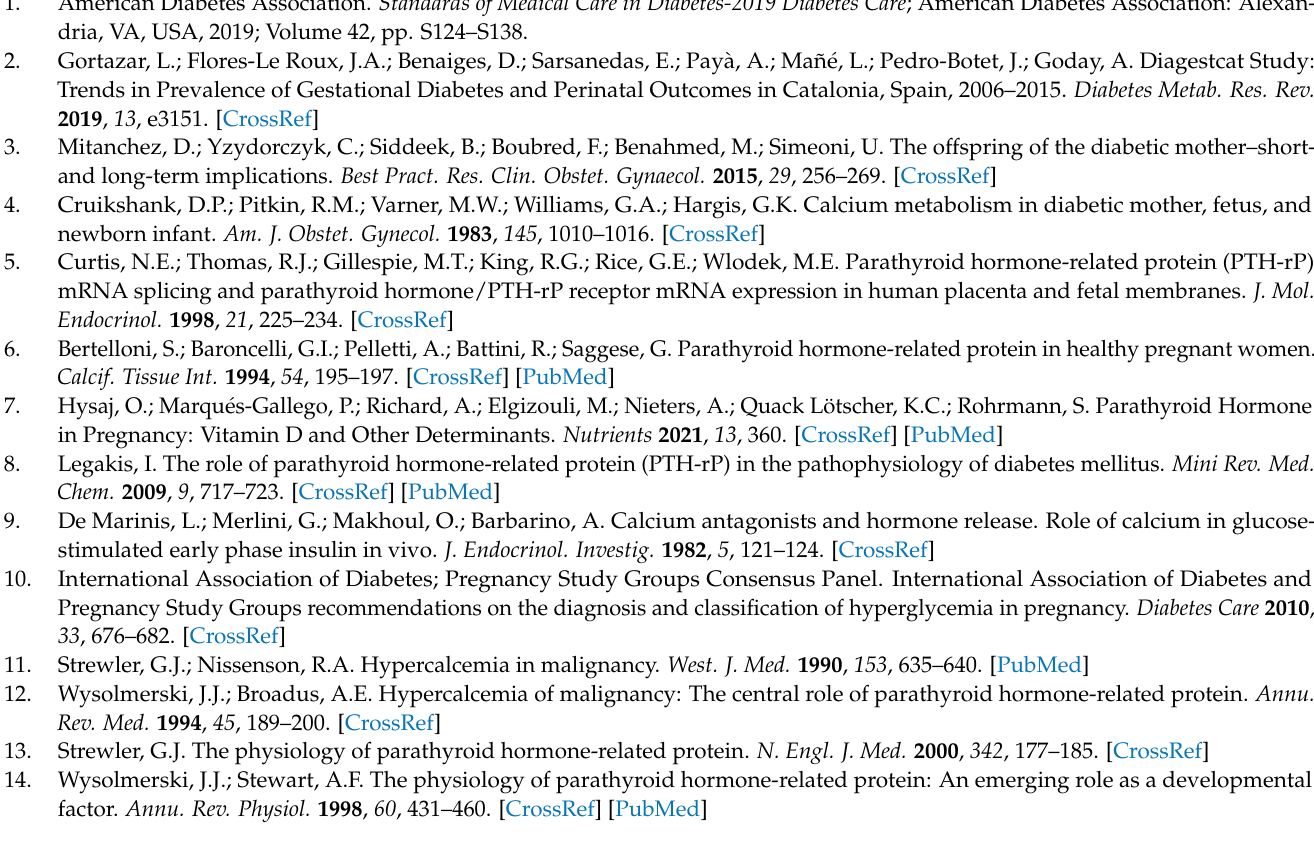
cytotrophoblast according to maternal, pregnancy and neonatal characteristics, Table S3: PTH-rP expression in syncytiotrophoblast according to maternal, pregnancy and neonatal characteristics, Table S4: PTH-R1 expression in syncytiotrophoblast according to maternal, pregnancy and neonatal characteristics, Table S5: PTH-rP expression in villous cytotrophoblast according to maternal, preg- nancy and neonatal characteristics, Table S6: PTH-rP expression in decidua according to maternal, pregnancy and neonatal characteristics, Table S7: PTH-R1 expression in villous cytotrophoblast according to maternal, pregnancy and neonatal characteristics, Table S8: PTH-R1 expression in decidua according to maternal, pregnancy and neonatal